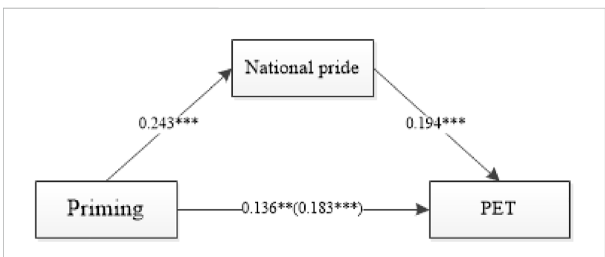
FIGURE 3 Theresultsofmediatingeffect.Note:Theindependentvariableis prime, prime = 1, 2, and 3 if the observations are from control group, hcvideo group, and pevideo group, respectively. The dependent variable are rating of PET. The mediating variable is rating of national pride. *** p < 0.01, ** p < 0.05, * p <